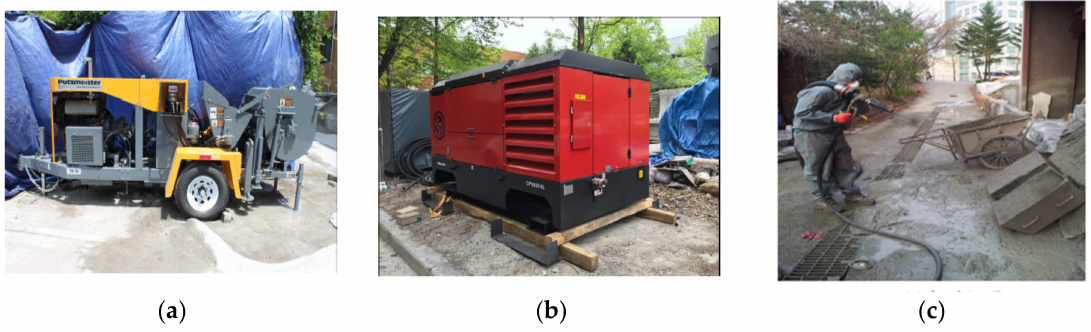
Figure 2. ( a )Shotcreteequipmentwithmixer,( b )aircompressor,( c )shootinginthepanel,shotcretingmethod.